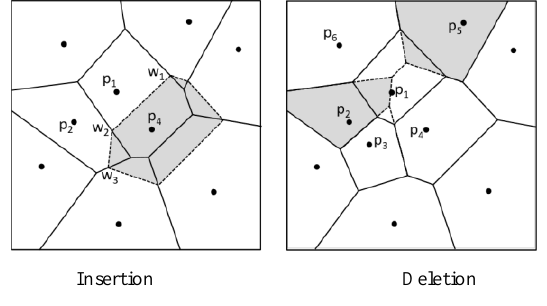
Figure 7. Data update on VoMR-tree